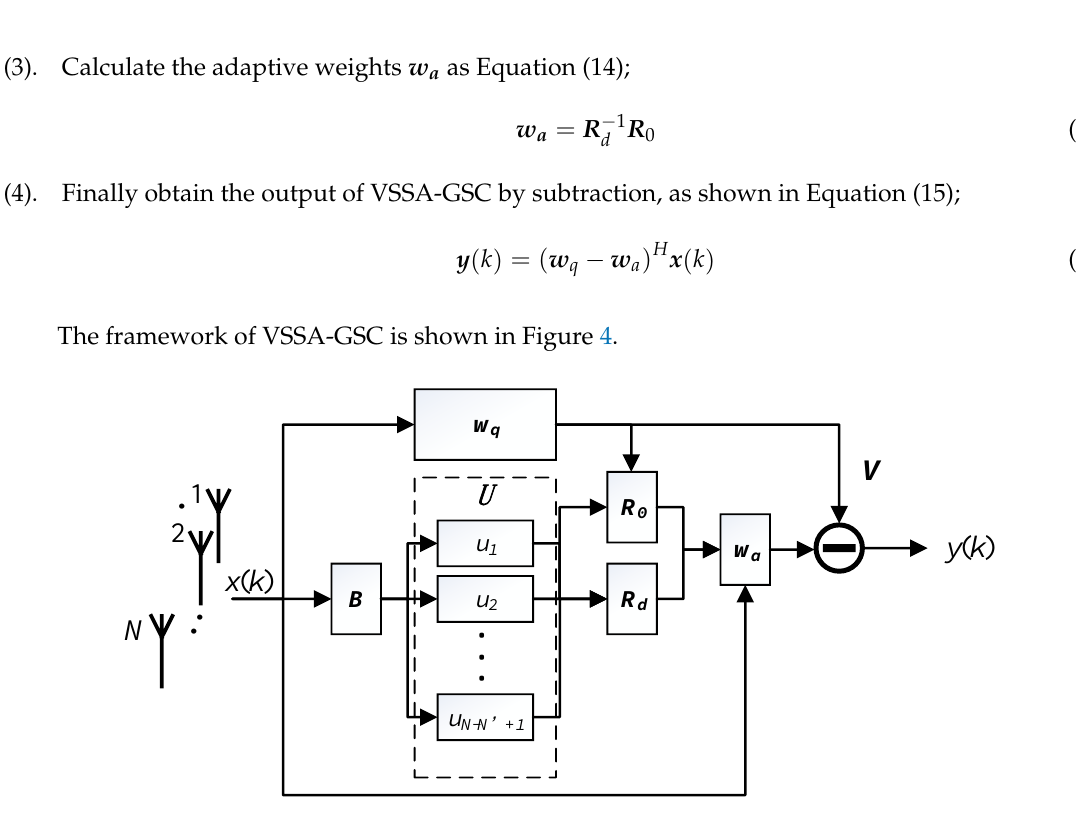
Table 1. The information of the injected targets.